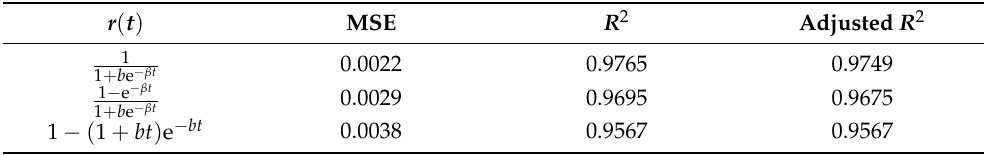
Table 1. The values of MSE, R 2 , and Adjusted R 2 of r ( t ) for